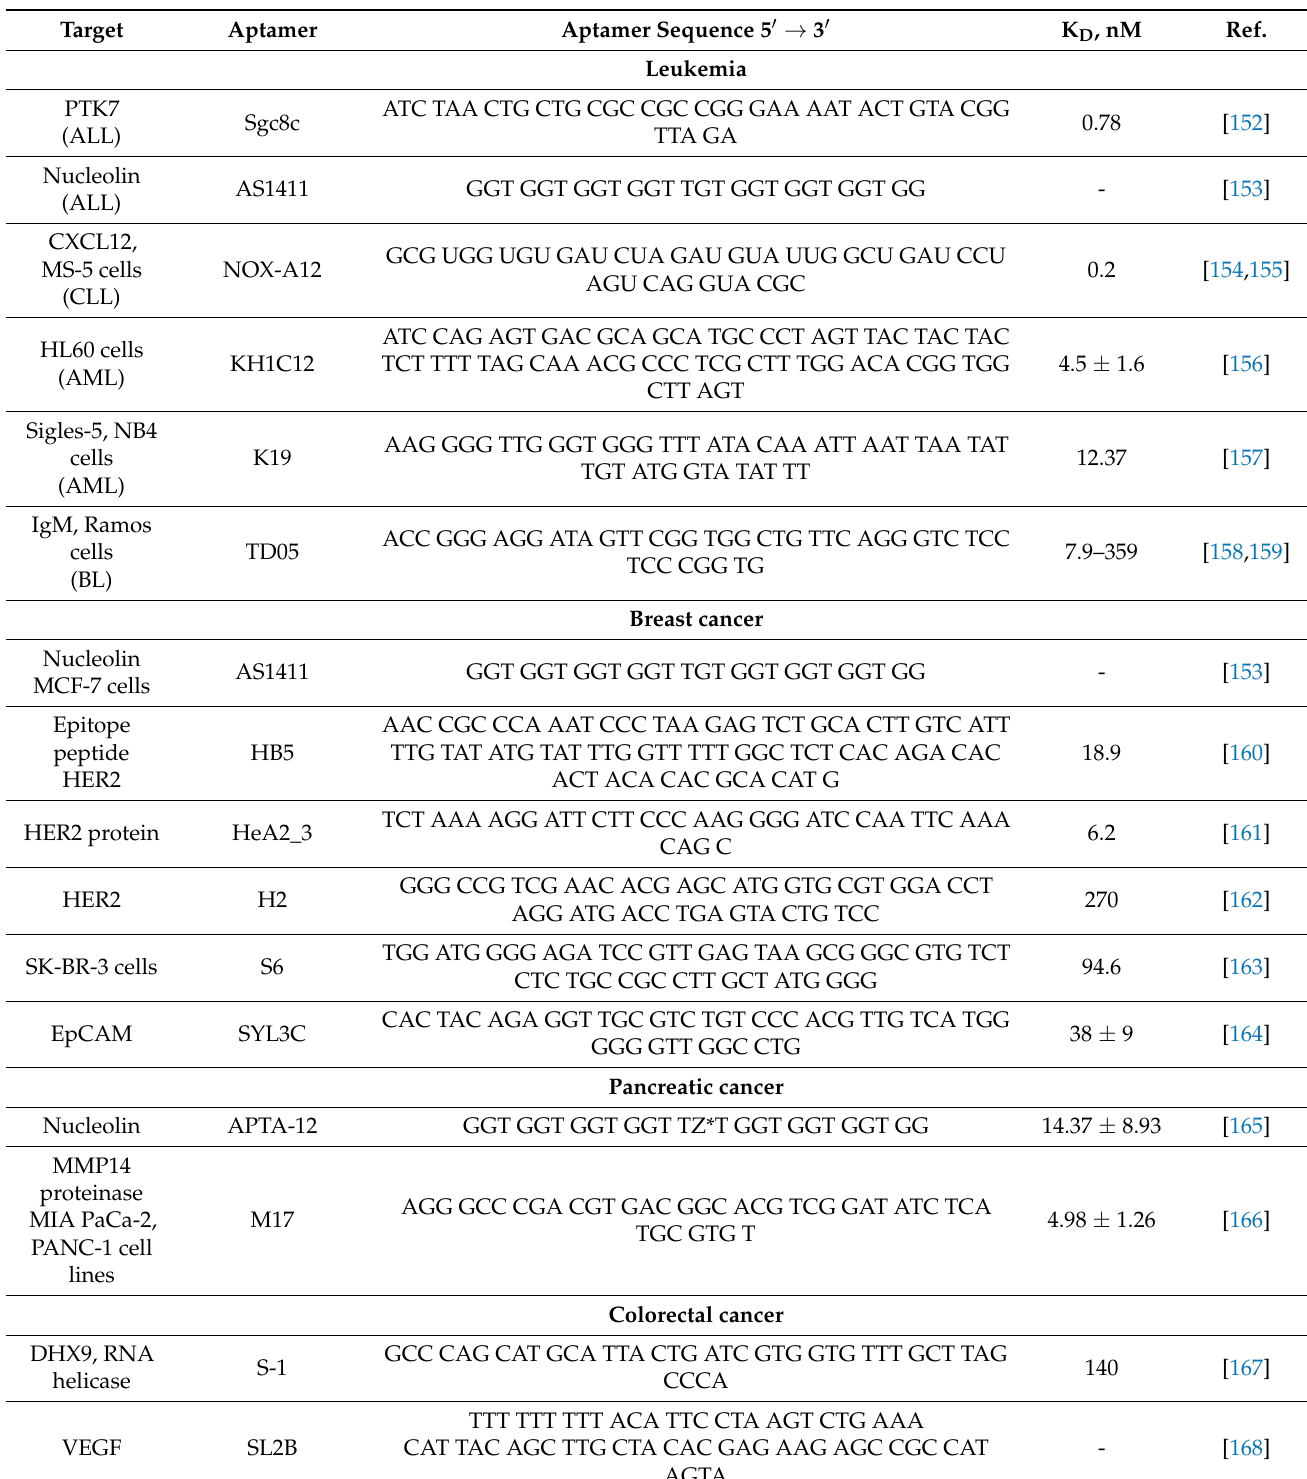
Table 2. DNA/RNA aptamers to various types of